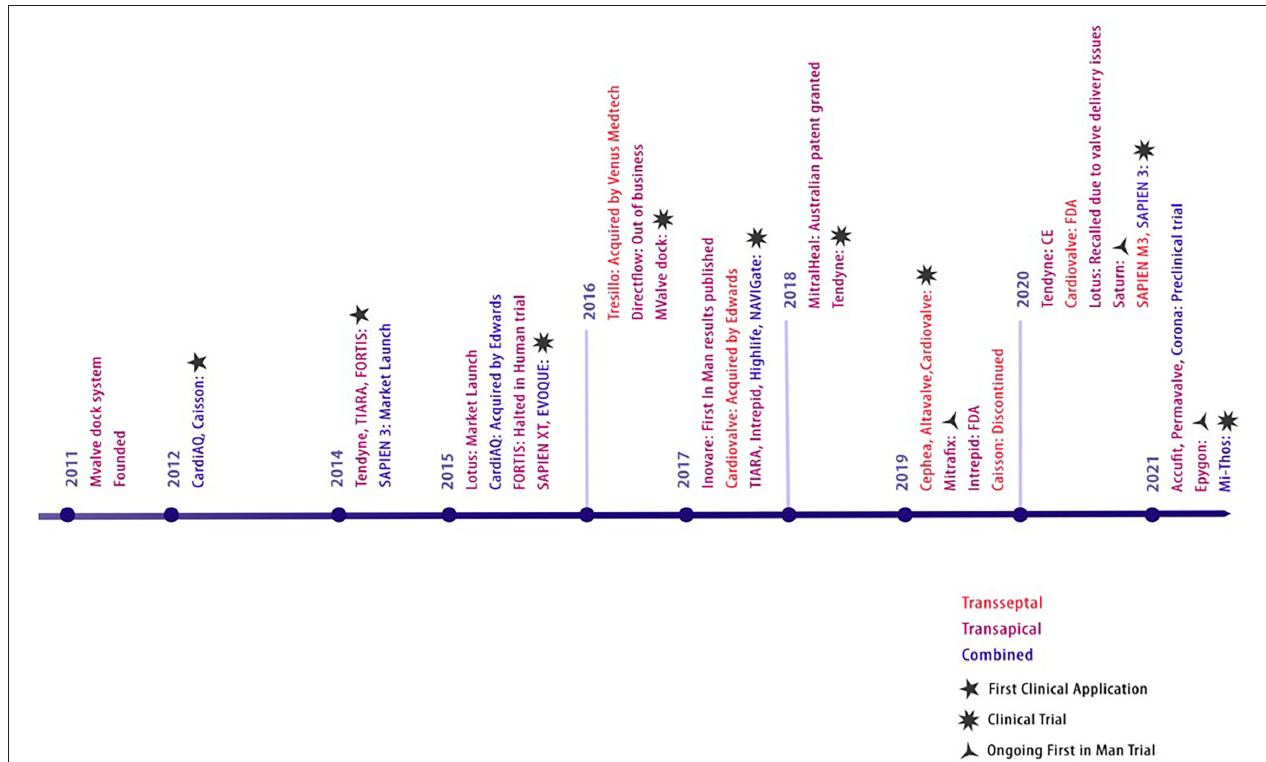
FIGURE 1 | Evolution of TMVI devices. Evolution of transcatheter prosthesis for mitral valve